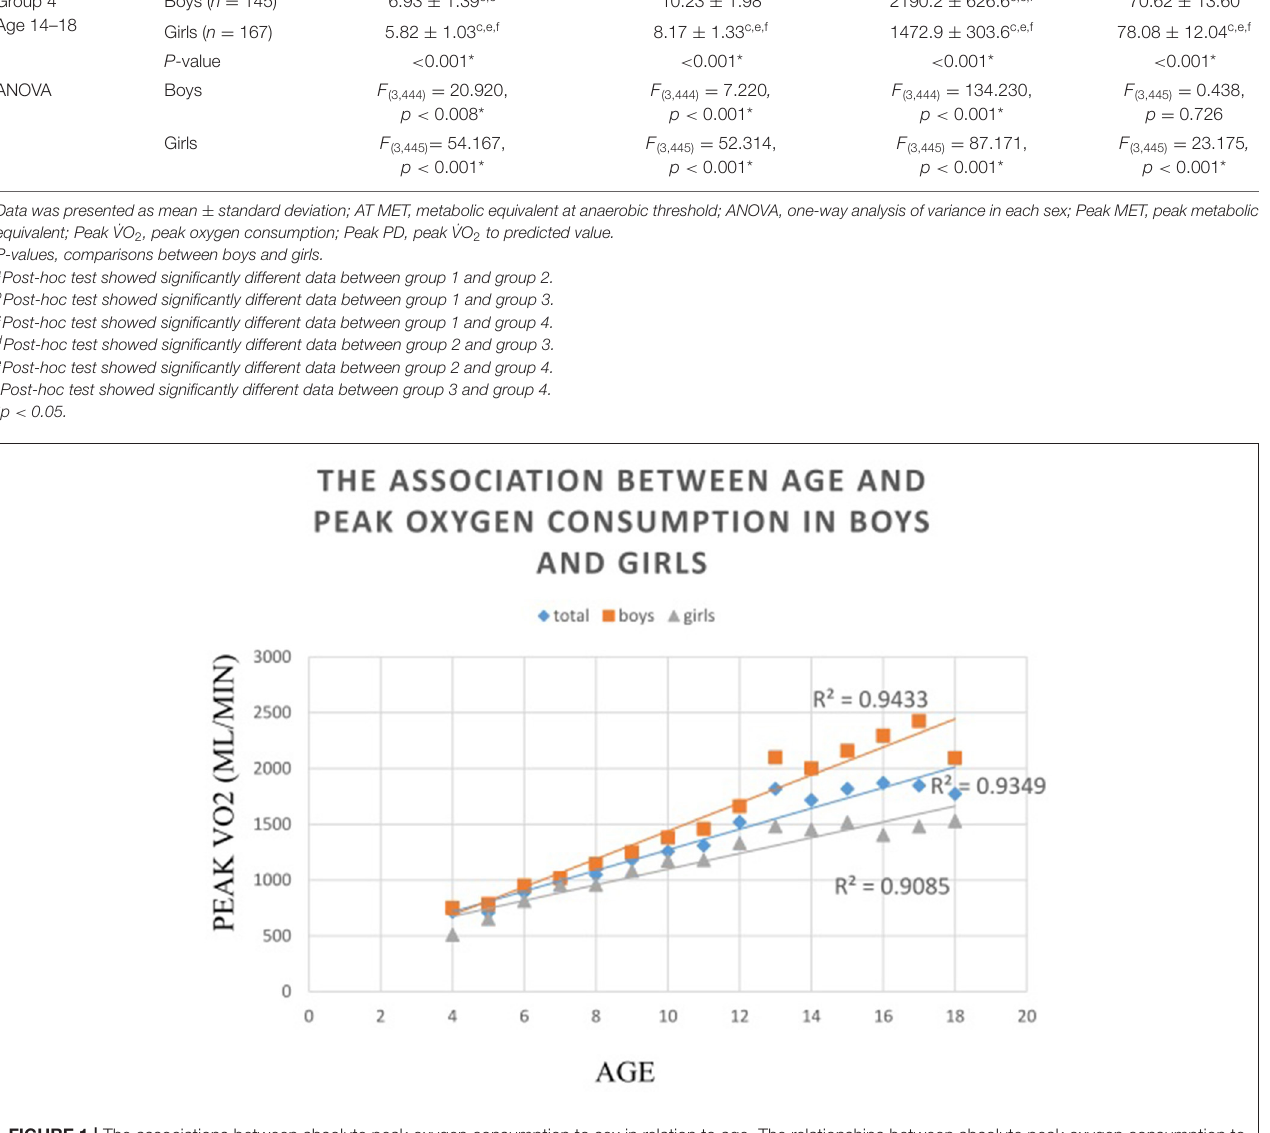
FIGURE 1 | The associations between absolute peak oxygen consumption to sex in relation to age. The relationships between absolute peak oxygen consumption to age are illustrated in this figure. Age significantly ( P < 0.001) correlated with peak VO2 in all participants, boys, and girls, with coefficients of determination ( R 2 ) of 0.9349, 0.9433, and 0.9085,